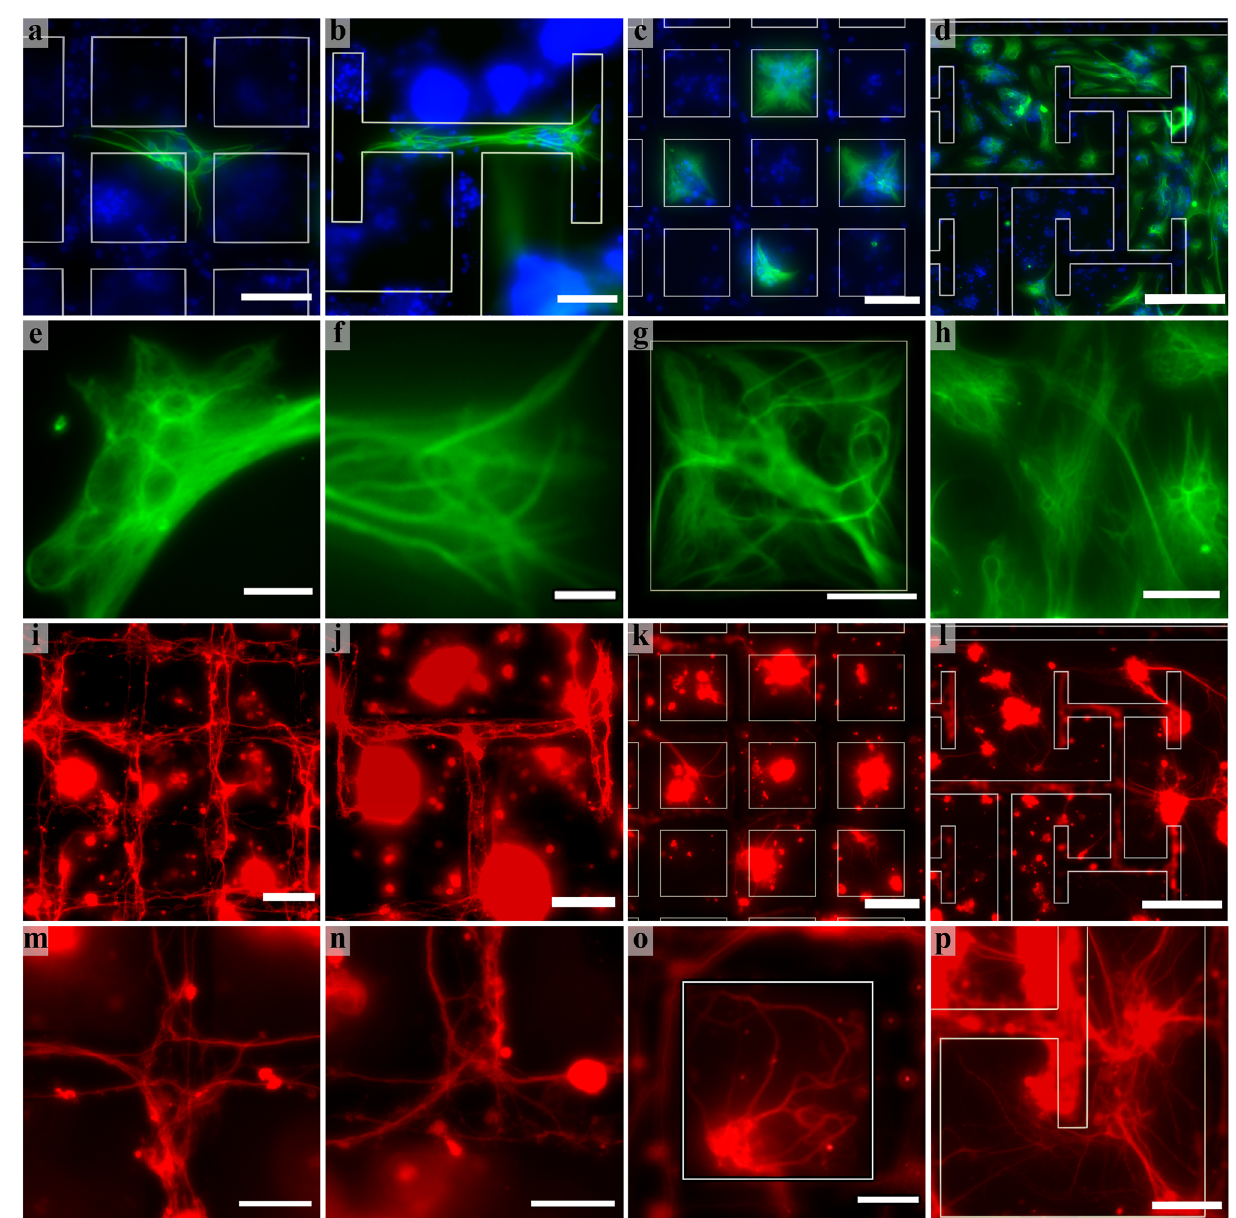
Figure 2. Representative examples of fluorescence images of retinal cells interacting with the grid and fractal electrodes at 17 DIV (green = GFAP labelled glia; red = β-tubulin III labelled neurons; blue = DAPI labeled nuclei). Glia on the VACNT surfaces of the ( a ) grid and ( b ) fractal electrodes. Glia accumulating on the SiO 2 surfaces of the ( c ) grid and ( d ) fractal electrodes. The structure of glia on the VACNT surfaces of the ( e ) grid and ( f ) fractal electrodes as well as the SiO 2 surfaces of the ( g ) grid and ( h ) fractal electrodes. Neuron processes following the VACNT electrodes of the ( i ) grid and ( j ) fractal electrodes. ( k ) Neuron clusters inside the grid chambers sending processes towards the VACNT sidewalls. ( l ) Large neuron clusters on the SiO 2 surface connecting to the neurons on the VACNT surface of a fractal electrode. Neuron processes following the VACNT electrodes of the ( m ) grid and ( n ) fractal electrodes. ( o ) Neuron cluster attached to the VACNT sidewall of a grid chamber sending processes onto both the SiO 2 and VACNT surfaces. ( p ) Neuron clusters and connecting processes on the SiO 2 and VACNT surfaces of a fractal electrode. The images in ( c ) and ( k ) show the same FOV, as do ( d ) and ( l ). Electrode edges are highlighted with white lines except for panels ( i ), ( j ), ( m ), and ( n ) which concentrate on the behavior of processes along the edges because the lines would have obscured these processes. Scale bars are: 10 µm in ( e ) and ( f ); 20 µm in ( g ), ( h ), ( m ), ( n ), and ( o ); 40 µm in ( p ); 50 µm in ( a ), ( b ), ( c ), ( i ), ( j ), and ( k ); and 100 µm in ( d ) and ( l